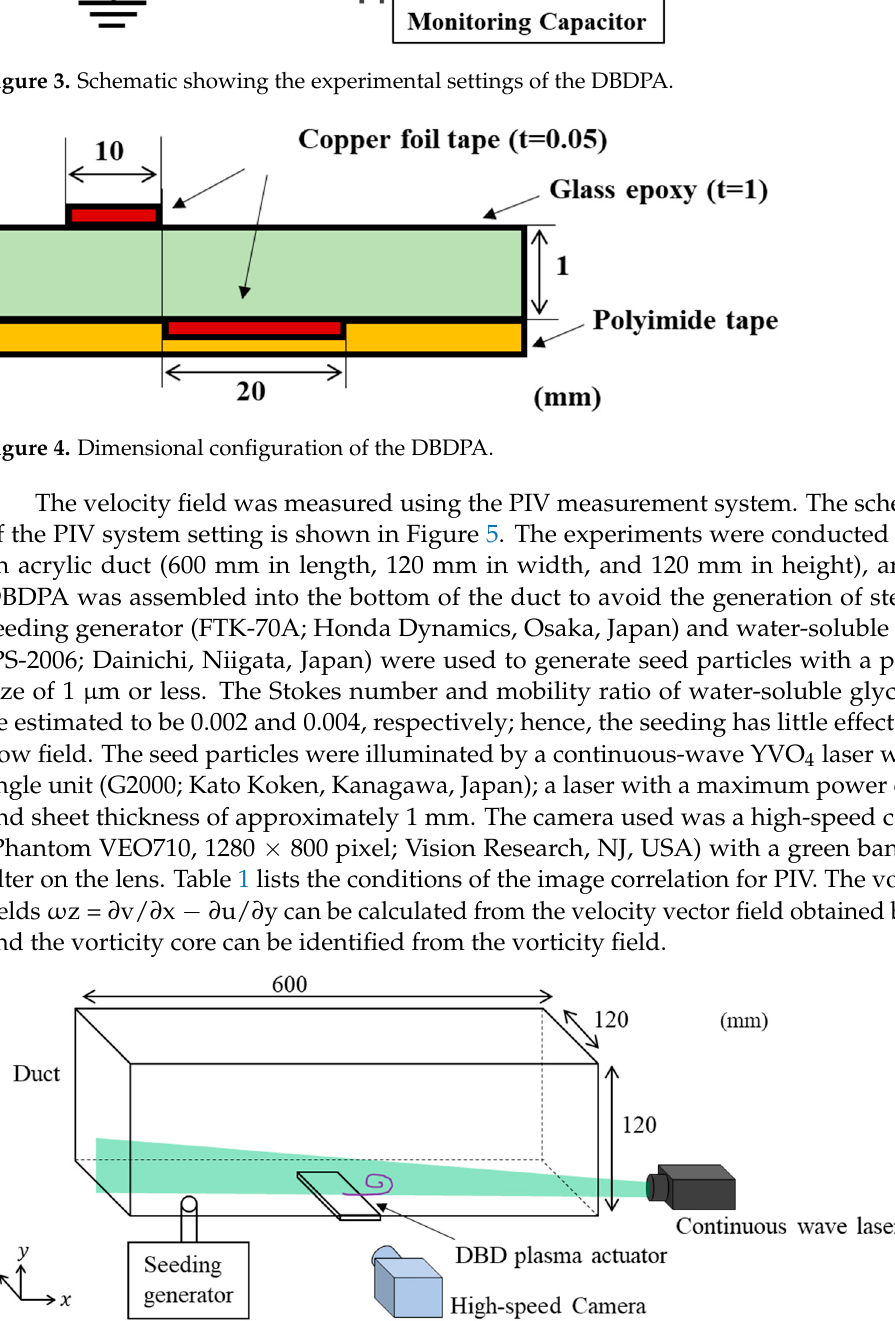
Figure 5. Experimental setup for the PIV measurement system. Table 1. Conditions for calculating the velocity field.